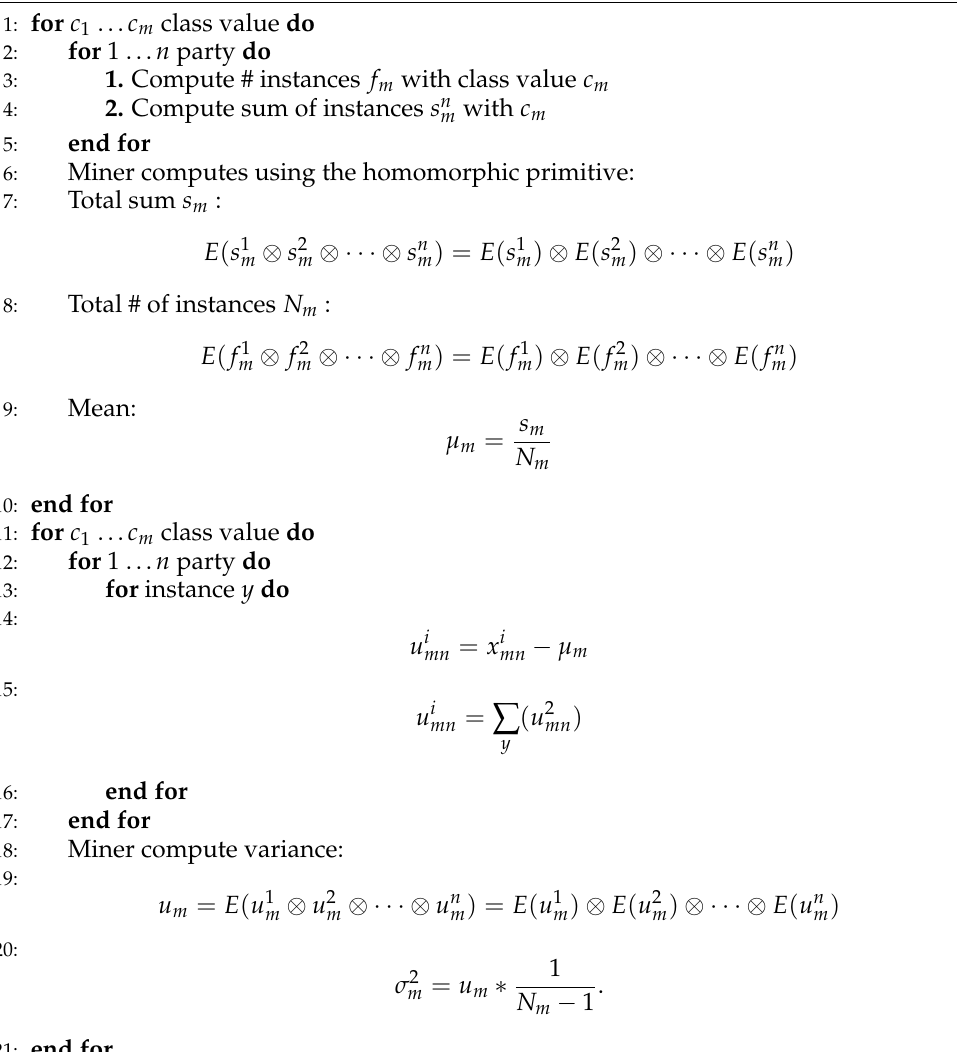
Algorithm 2 : Protocol for numeric attribute